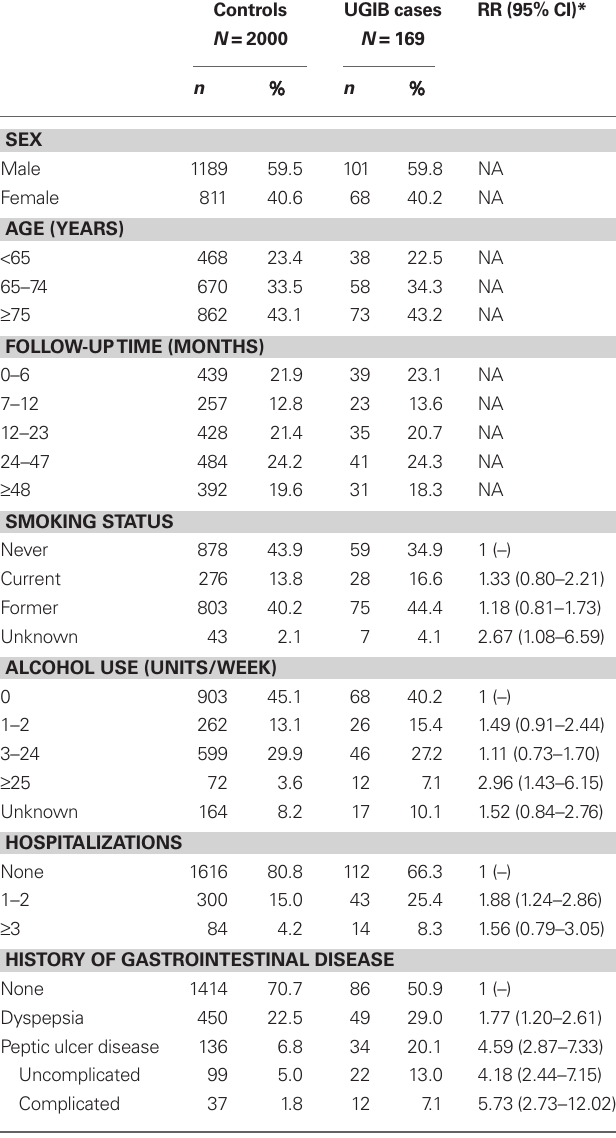
Table 1 | The prevalence of demographic and lifestyle characteristics in individuals with ugiB and controls with no ugiB, and their association with a diagnosis of ugiB, in a cohort of low-dose ASA users.